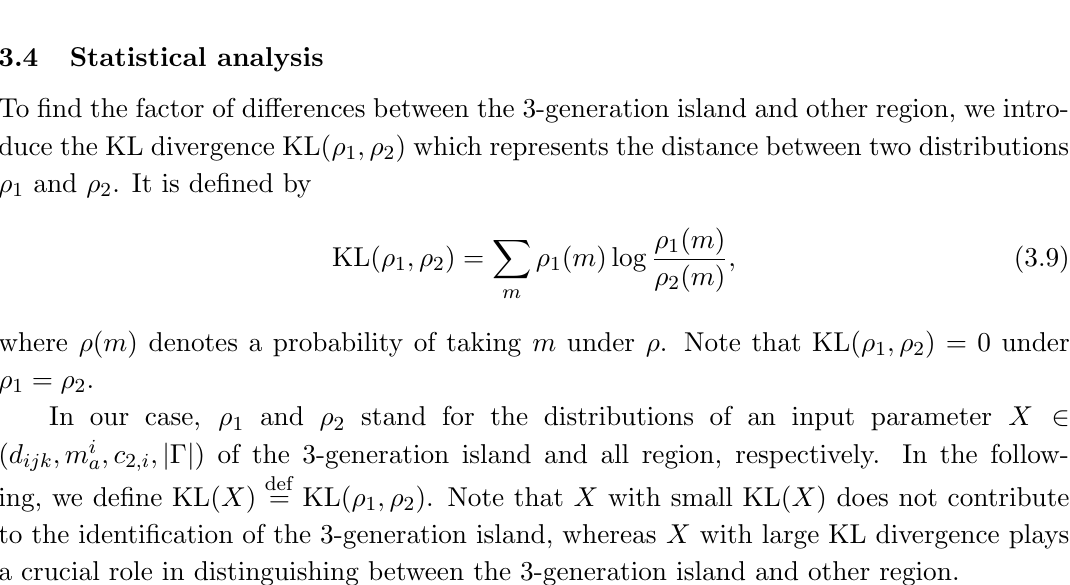
Algorithm 3 . Elbow